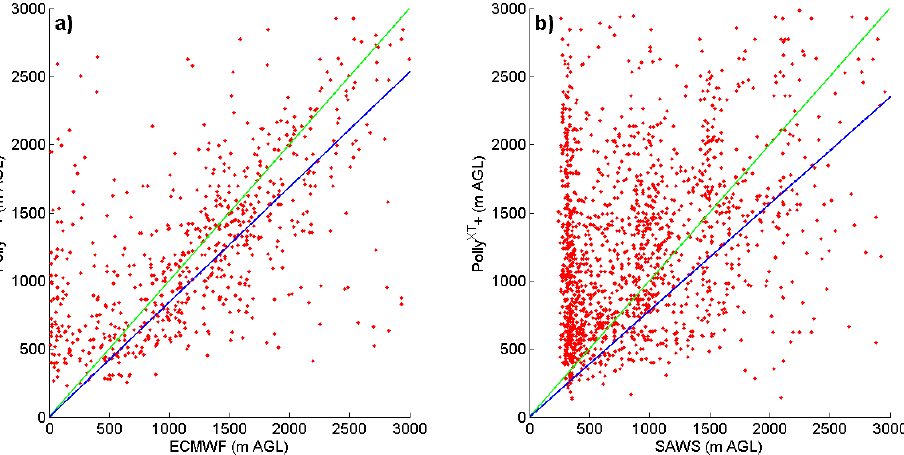
Fig. 8. Scatter plot between Polly XT and ECMWF (a) and Polly XT and the SAWS-operated model (b) for convective (08:00–17:00) condi- tions. The green and the blue lines represent a 1 : 1 correspondence and linear fit to data,